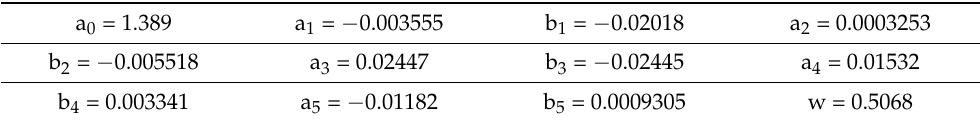
Table 5. The sym series wavelet packet base corresponded to the parameter value of the MSE fitting function.